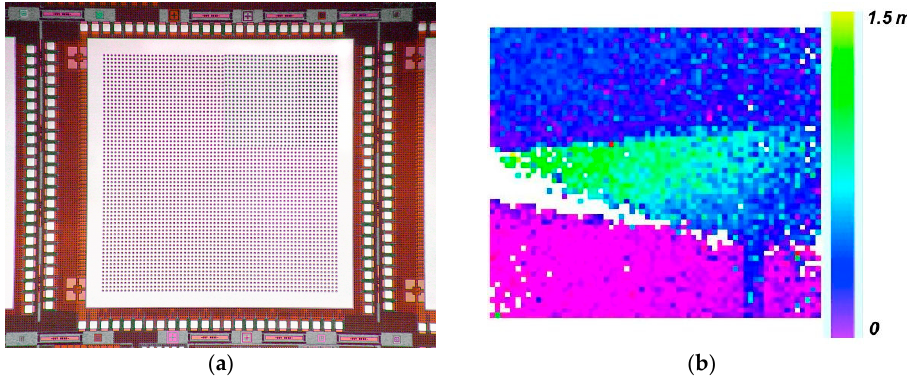
Figure 11. ( a ) 64 × 64-pixel lidar focal plane fabricated by 3D integration of a GMAPD array with two tiers of SOI CMOS circuitry ( b ) Lidar image of a cone obtained by illumination from a doubled Nd:YAG microchip laser.